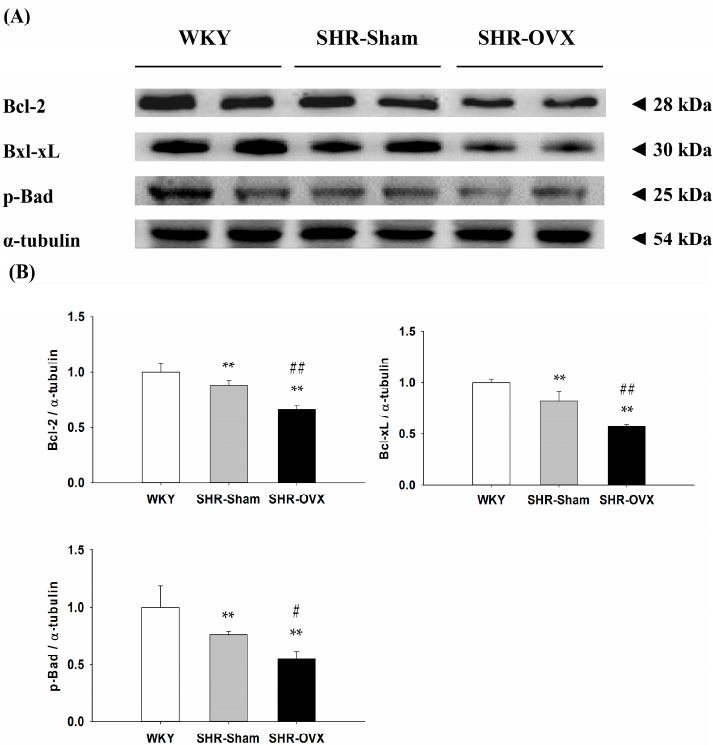
Figure 3. ( A ) The two representative protein products of Bcl-2, Bcl-xL and p-Bad extracted from the left ventricles of excised hearts from the Wistar Kyoto rats (WKY), SHR with sham-operated (SHR-Sham) and SHR with bilateral ovariectomized (SHR-OVX) were measured by Western blot analysis; ( B ) The bars represent the relative protein quantification of Bcl-2, Bcl-xL and p-Bad on the basis of α -tubulin and the average protein expression levels in the WKY group normalized to one, and then, a relative protein expression was calculated for each condition. Data presented as the mean values ± SD ( n = 8 in each group); ** p < 0.01 denotes significant differences from the WKY group; # p < 0.05, ## p < 0.01 denote significant differences between the SHR-Sham group and the SHR-OVX group.